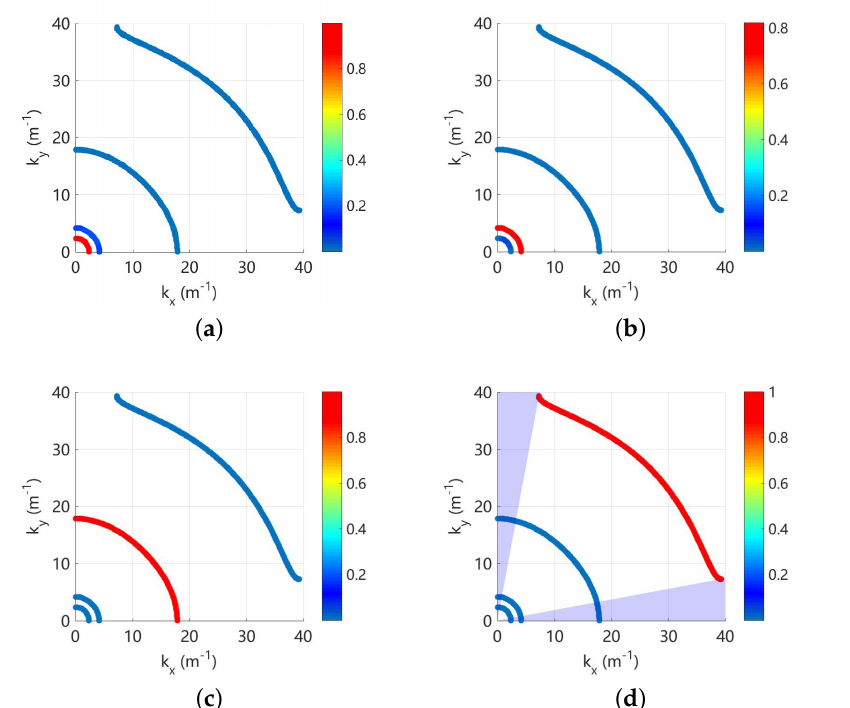
Figure 8. Wavenumber of the propagation waves at 800 Hz, coloured by: ( a ) RSW l ; ( b ) RSW s ; ( c ) RSW e ; and ( d ) RSW f . The purple area in sub-figure ( d ) indicates the identified Bragg band gap for the flexural